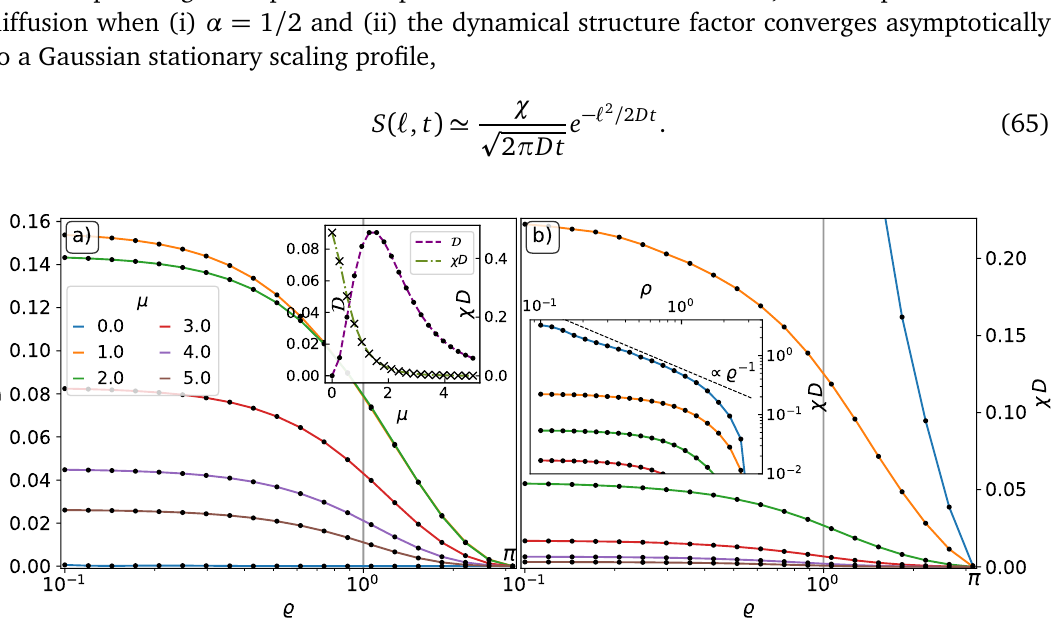
Figure 4: (a) Spin Drude weight D and (b) diffusion constant D in the discrete Landau–Lifshitz model, cf. Eq. 4, in the easy-axis regime, depending on the chemical potential µ and the anisotropy (cid:37) . (a, inset) Drude weight (purple) and diffusion constant (olive green) as functions of µ at (cid:37) = 1 (vertical grey line). (b, inset) Di- vergence of D at zero average magnetization, µ = 0 (blue curve), in the isotropic limit (cid:37) → 0, compared to ∼ 1 /(cid:37) power-law scaling (black dashed line). Simulation parameters: τ = 1, L = 2 12 , averaged over 10 5 initial